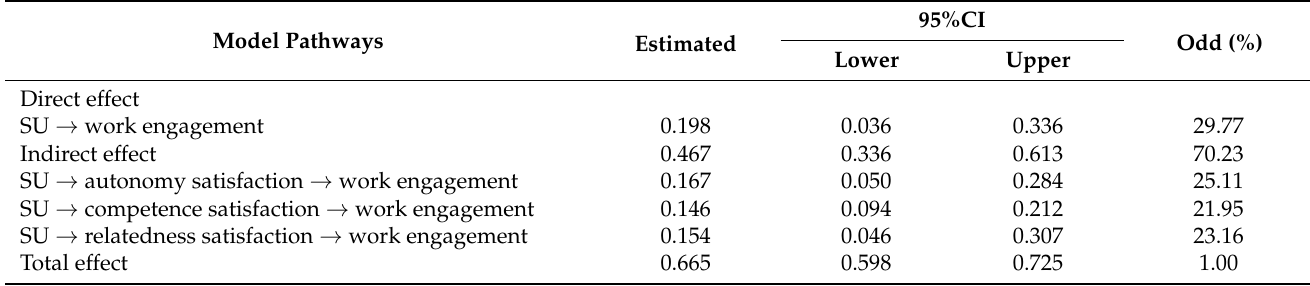
Table 3. Test of direct and indirect